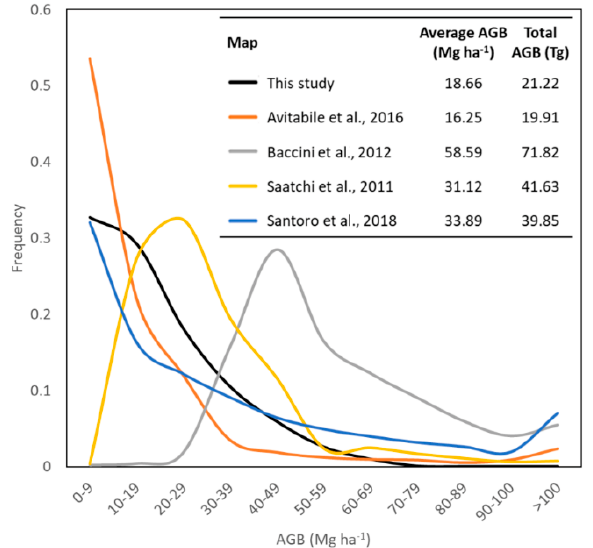
Figure 7. Distribution of the AGB intervals, average, and total AGB observed in this study and in four comparison maps for the Rio Vermelho watershed, Goiás State, Brazil. All the maps were resampled to 1-km resolutions.